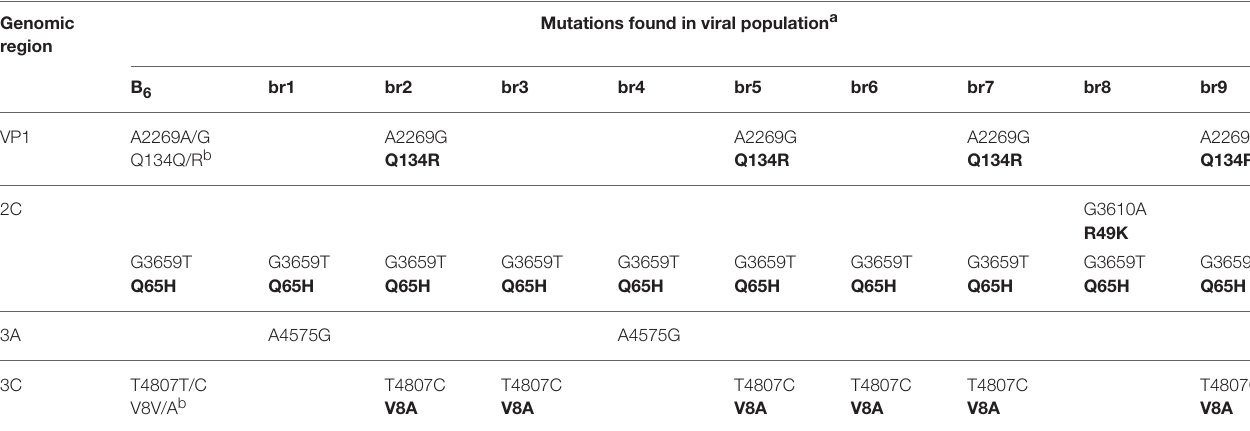
TABLE 2 | Mutations found in the genome of SVDV mutants with increased resistance to BFA. Genomic region